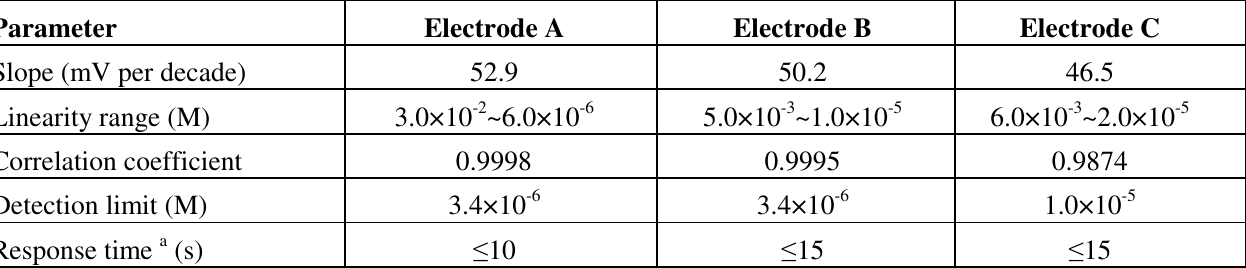
Table 1. Response Characteristics of the